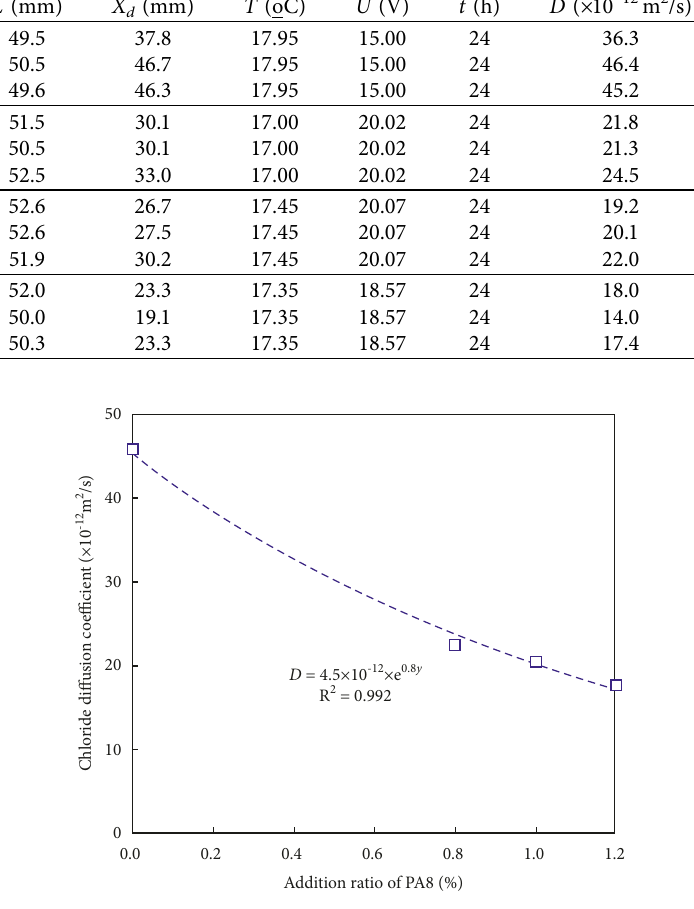
Figure 6: Relationship between the chloride diffusion coefficient D and the addition ratio of